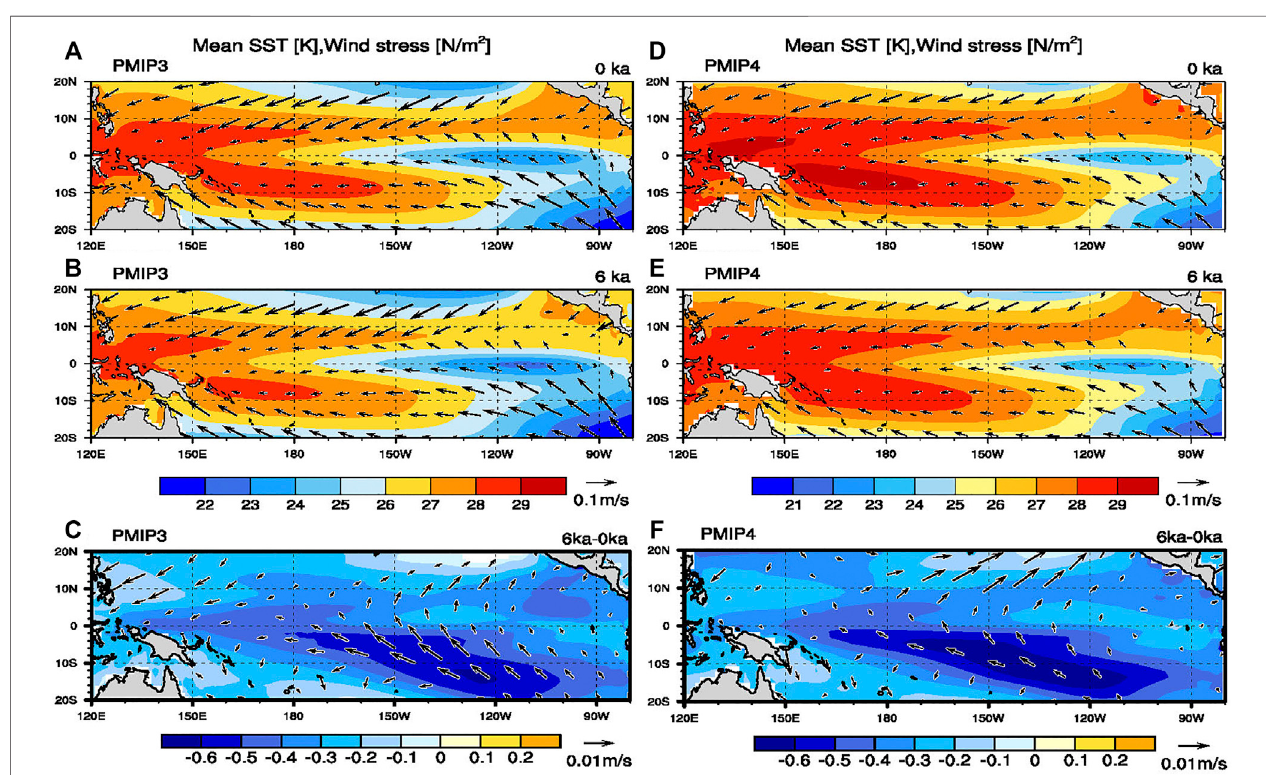
FIGURE1| PlotsforMMEofmeanSSTandsurfacewindstressderivedfromPMIP3(leftcolumn)andPMIP4(rightcolumn)models. (A) and (D) arePIsimulations; (B) and (E) are MH simulations; and (C) and (F) are their differences (MH minus PI). Shading and vector in (C) and (F) indicate the difference between MH and PI is signi fi cant at the 95% level by Student ’ s t